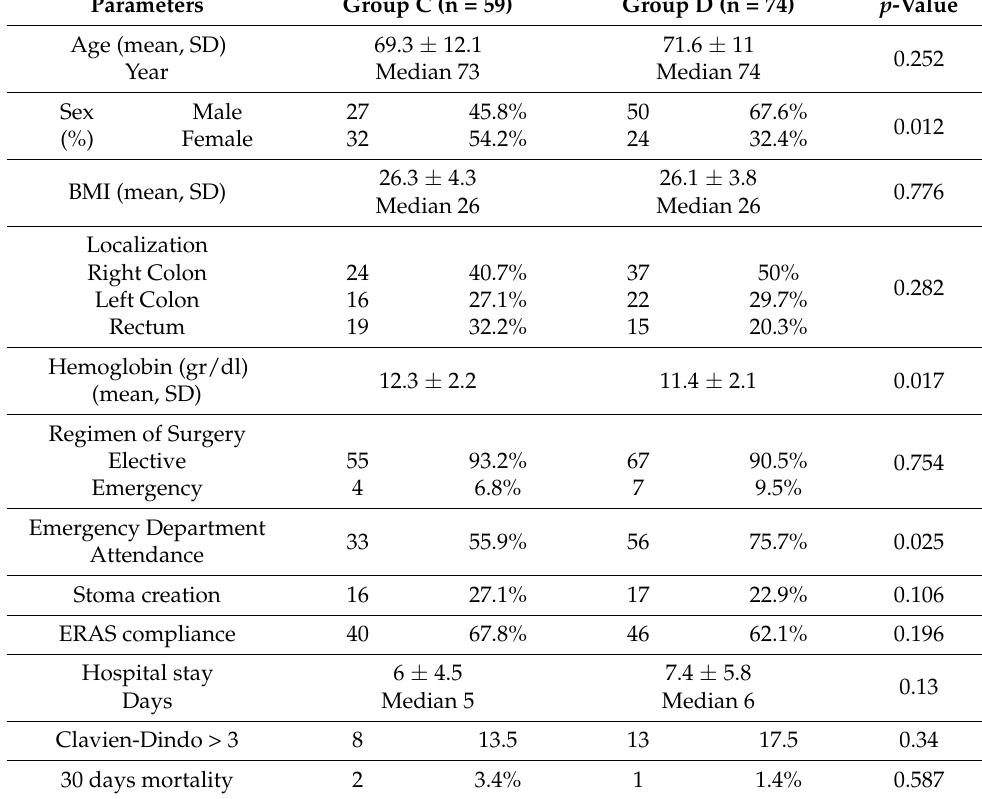
Table 6. Pre-operative and post-operative parameters for pandemic subset of analysis.